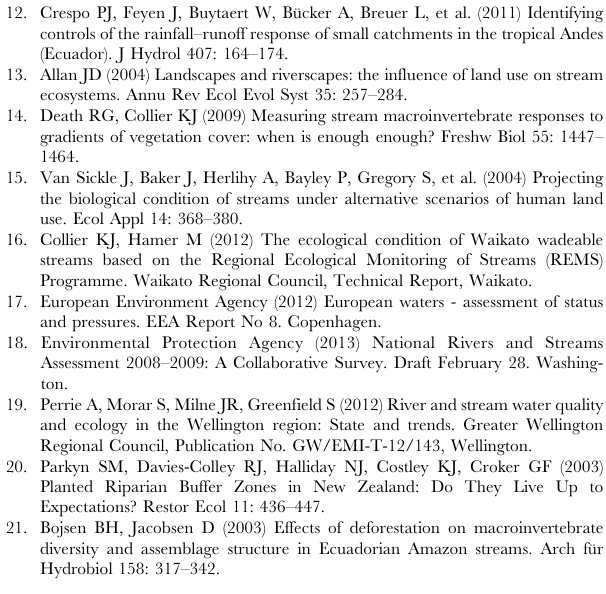
Table S1 List of environmental variables considered in the 23 studied Andean streams. Data of water parameters are means obtained from several measurements in two sampling campaigns. Altitude was determined once at the sampling sites. Catchment area and percentage of vegetation cover (VC) at three spatial scales were calculated in ArcGIS 9.3 Geographic Information System software. T = Temperature, SC= Specific Conductance, DO = Dissolved Oxygen, NO 3 2 = Nitrate, PO 43 2 = Phosphate, BOD 5 = Biochemical Oxygen Demand in Total Coliforms (TC) as Colony Forming Units or CFU. Table S2 Stepwise multiple linear regression analysis between macroinvertebrate metrics, land use and stream parameters for 23 Andean streams. Degrees of freedom for all regressions were 1, 20. AIC= Akaike Information Criterion used for selection of predictor variables. DO = Dissolved Oxygen, PO 43 2 = Phosphate, TC= Total